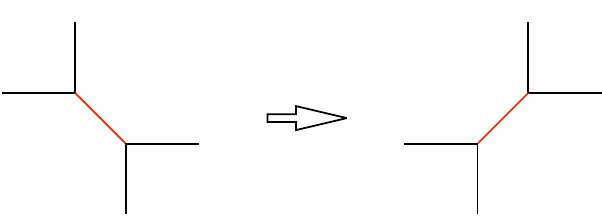
Figure 3. A local illustration of a (cid:13)op transition X in both diagrams correspond to the